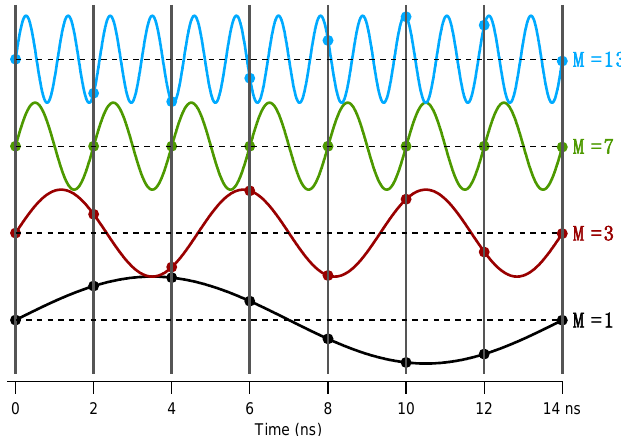
Figure 4. Illustration of the interleaved sampling of time channels using RF excitation of different frequencies in an example system with N = 7. Vertical lines represent the probe pulses, with markers representing the probed sample state. The black curve ( M = 1) represents the lowest possible frequency to be probed with this number of channels, at M ×500/ N MHz 71.42 MHz. In this case there is no interleaving, and the time channels are samples sequentially. The is not the case in the higher frequency red curve ( M = 3), where 3 periods fit in the time needed to get 7 probe pulses, which means the samples need to be sorted in chronological order. The green curve ( M = 7) represents a degenerate case (as M = N ). All pulses sample the same phase of the excitation, leaving only a static stroboscopic image. This is equivalent to the limited dynamics possible using a time integrating detector. The blue curve ( M = 13) is an example for a pumping frequency higher than the sample rate. Despite more than one period of excitation between sample points, the interleaved acquisition still yields the complete waveform (after the necessary sorting).